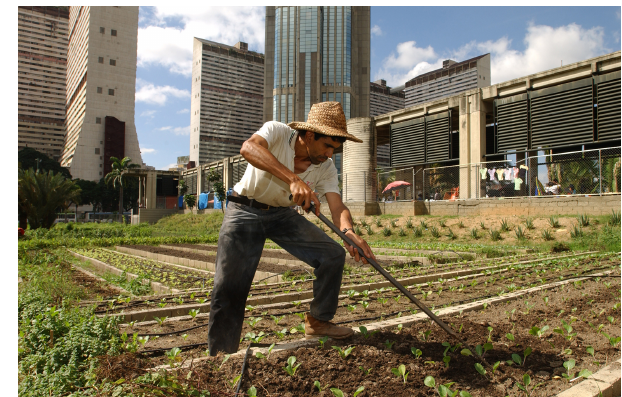
Figure 2. Urban and peri-urban agriculture to improve nutrition and livelihoods of poor families as part of the Special Programme for Food Security (SPFS) in Caracas, Venezuela. © FAO/Giuseppe